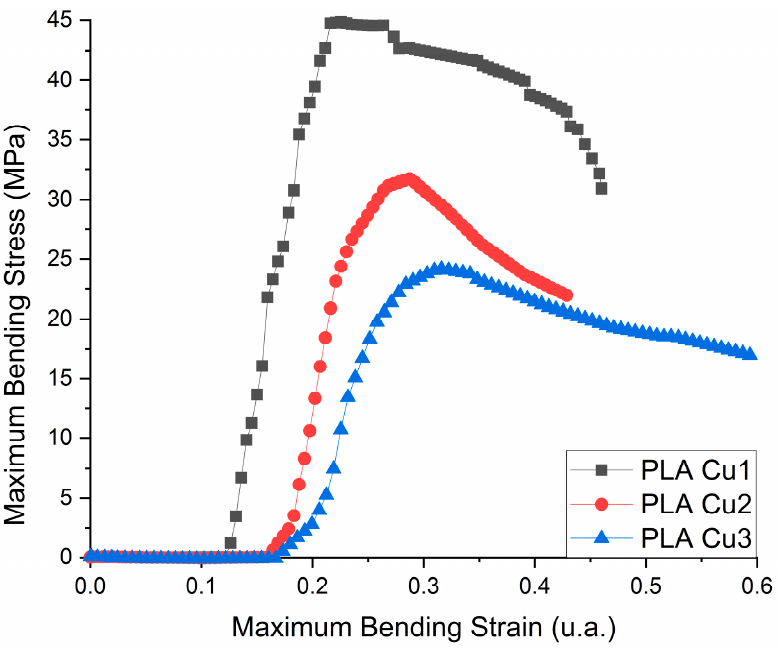
Figure 8. Flexural deformation curve of the PLA-Cu composite sample. Table 4. The obtained results for three points Flexural Tests.